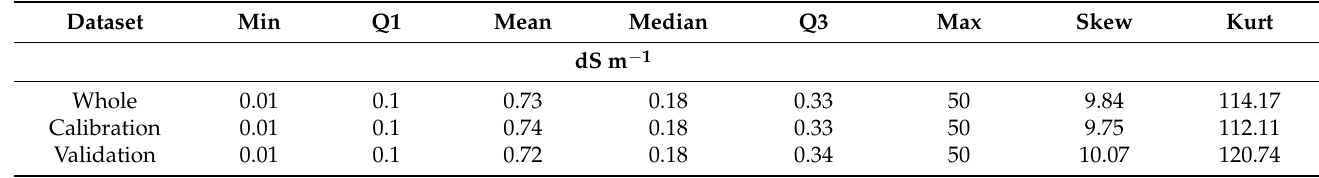
Table 1. Statistical summary of EC.